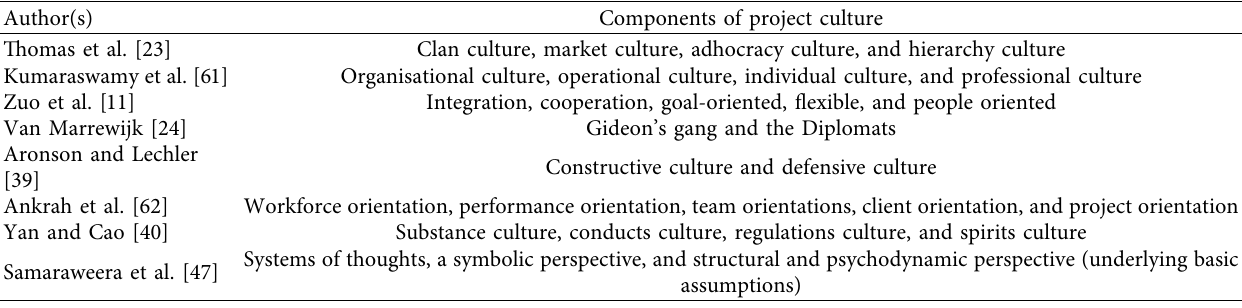
Table 2: Components of project culture in construction